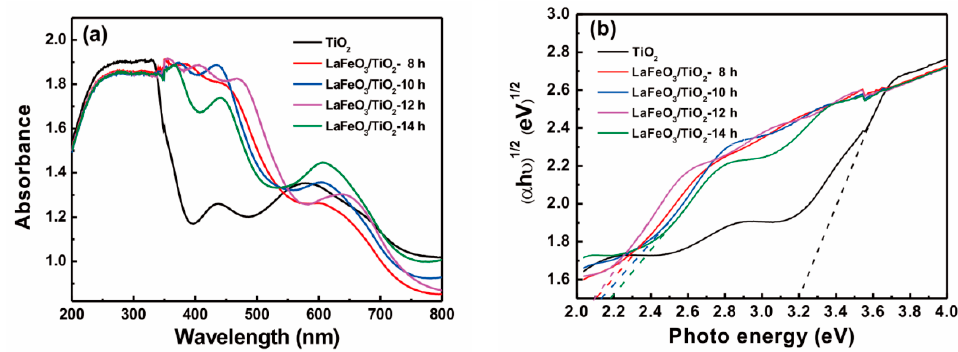
Figure 4. ( a ) DRS spectra and ( b ) ( α h υ ) 1/2 – h υ of TiO 2 nanotube arrays and LaFeO 3 /TiO 2 nanotube arrays with different hydrothermal reaction time.